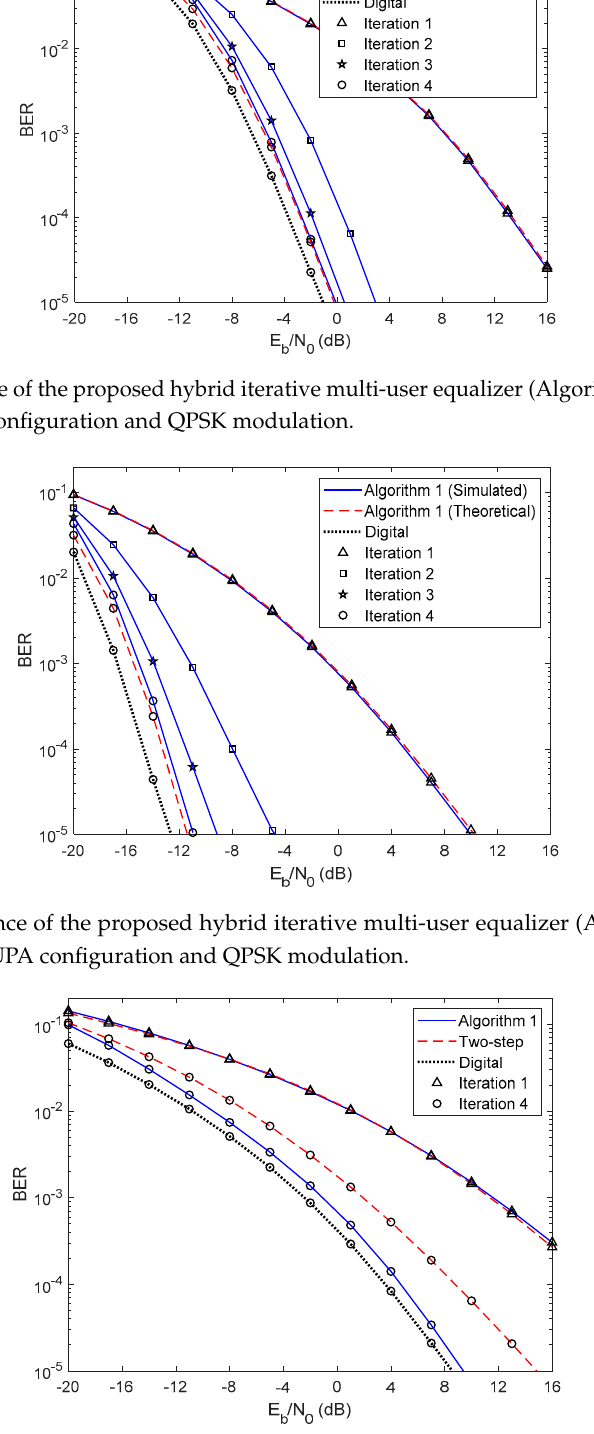
Figure 11. Performance comparison between the Algorithm 1 and the two-step approach for the NCSI